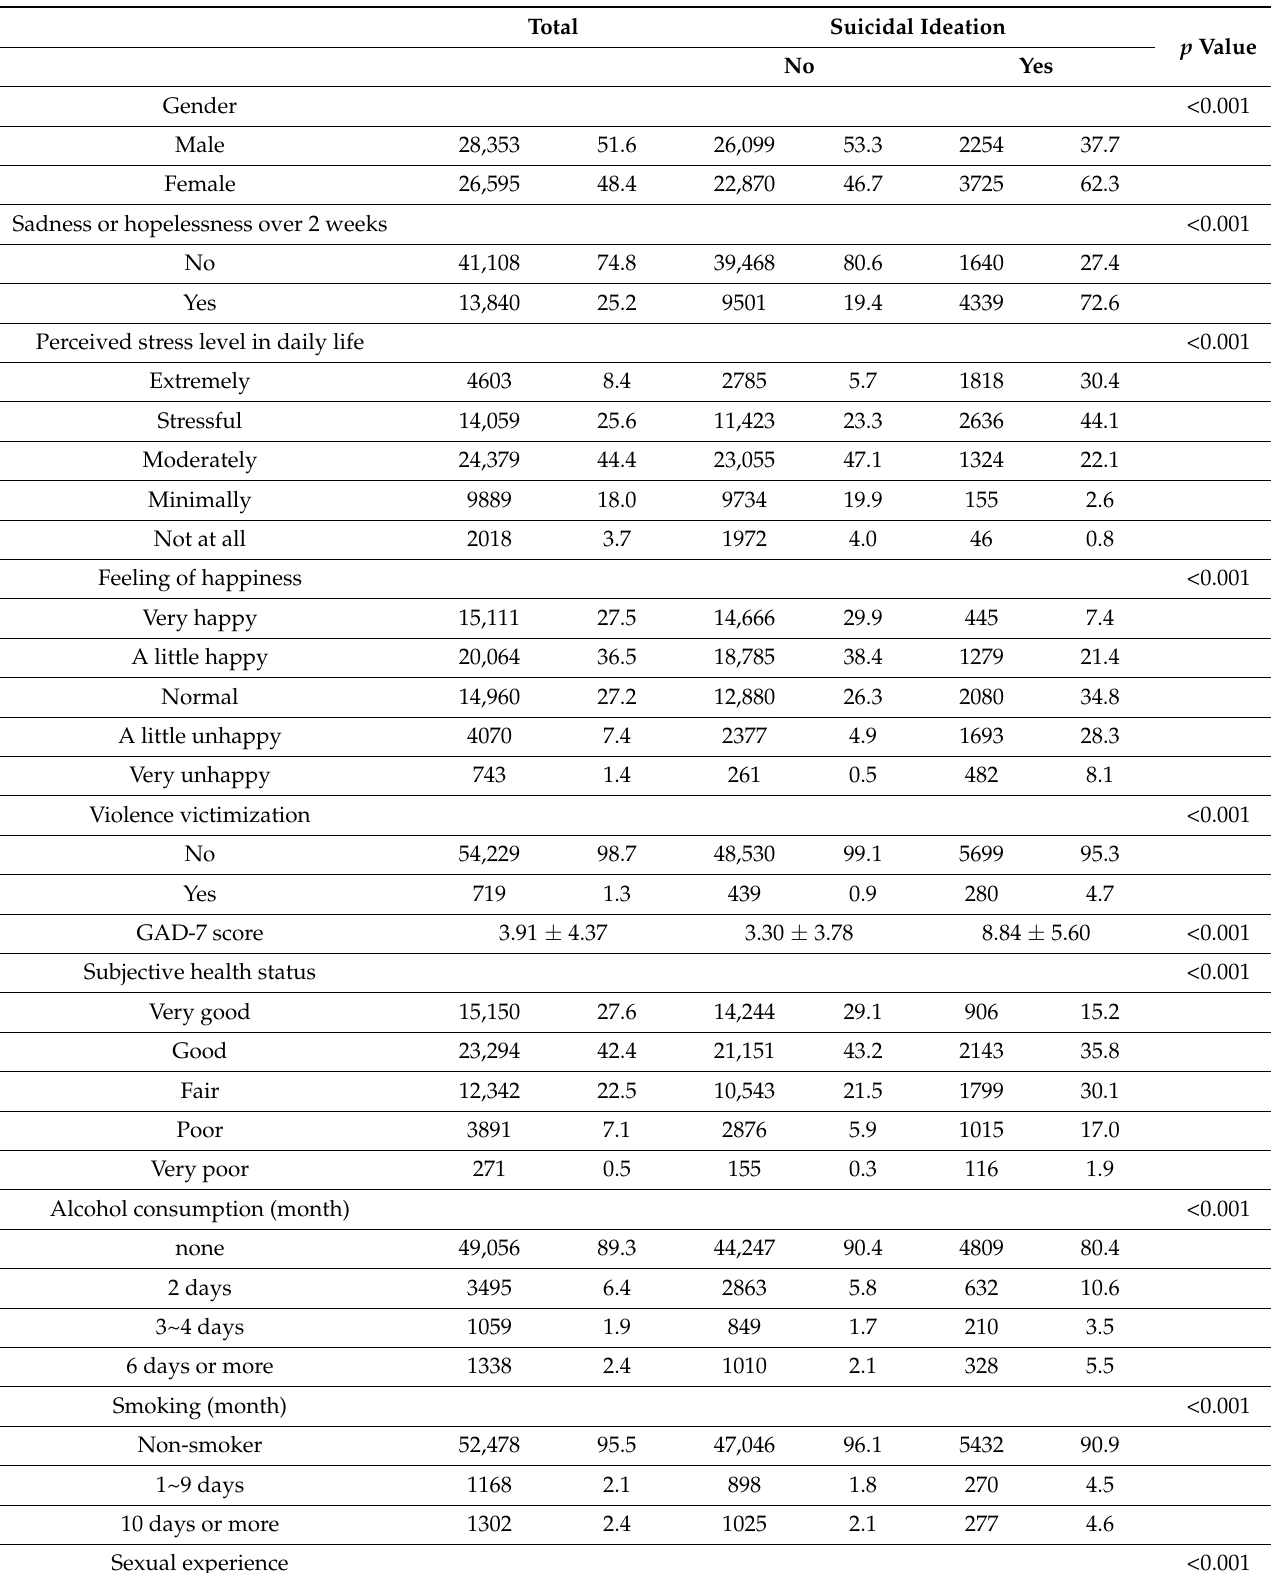
Table 1. General characteristics of the subject by suicidal